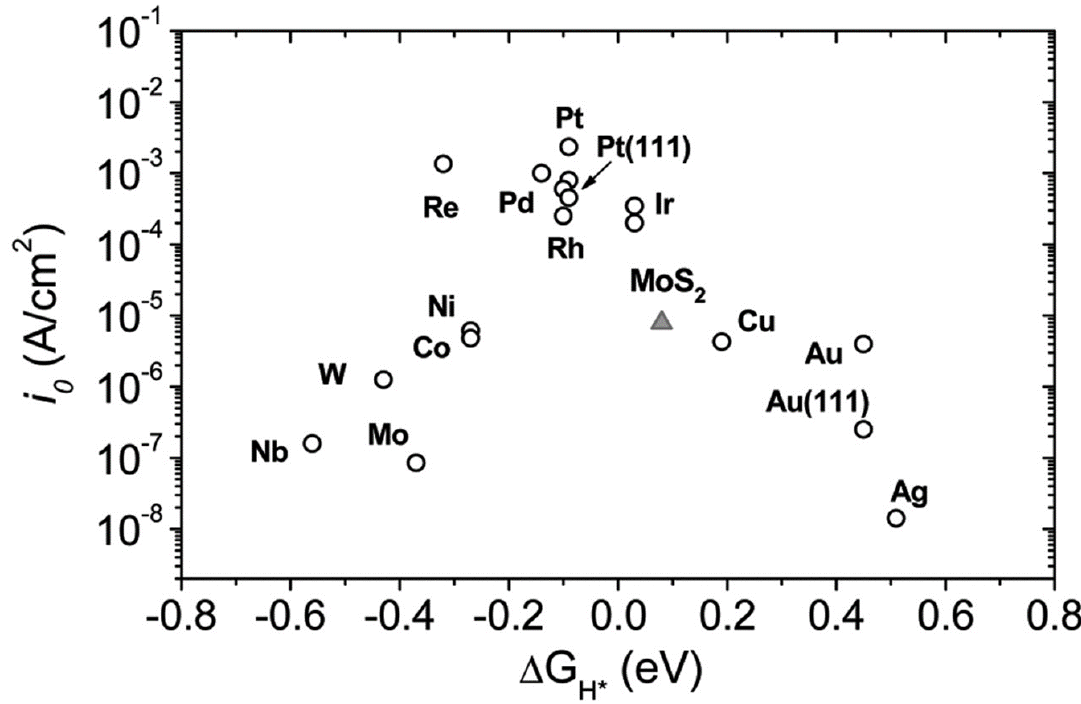
Figure 8. Volcano plot of the exchange current density as a function of the density functional theory (DFT)-calculated Gibbs free energy of adsorbed atomic hydrogen for nanoparticulate MoS 2 and the pure metals. Copyright 2007 Science.